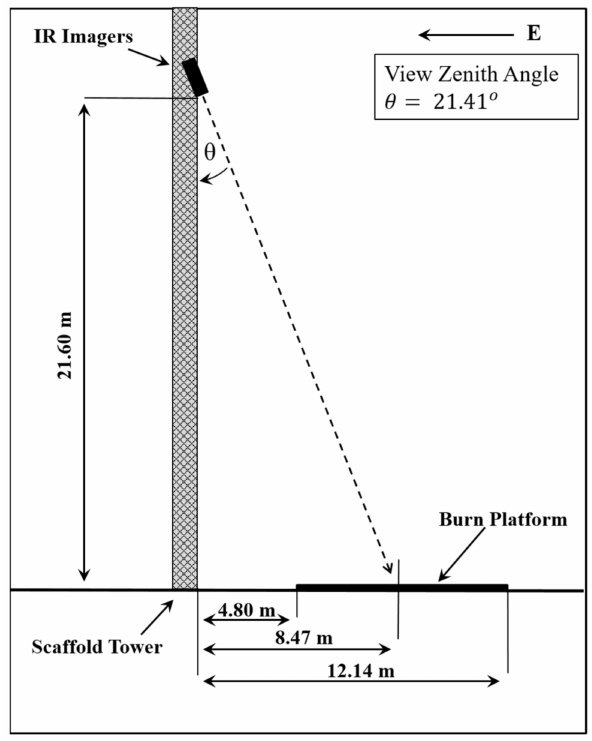
Figure 2. Visualization of the position of the Bomberos and FLIR SC6703 systems on the scaffold tower relative to the burn platform (not to